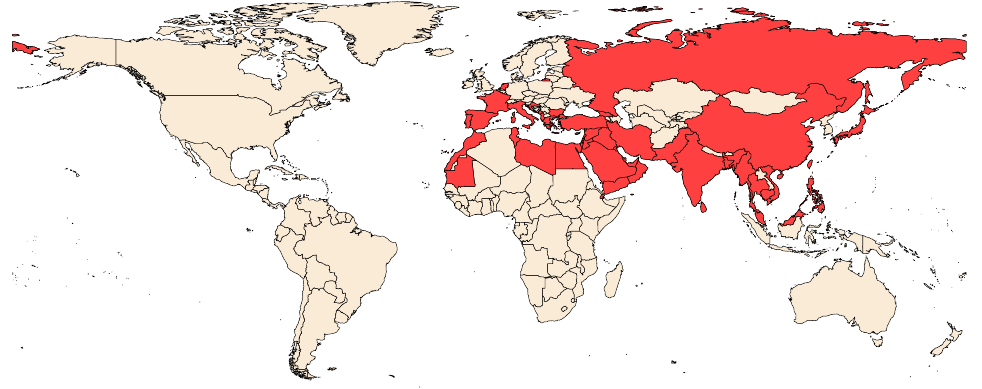
Figure 2. Geographic distribution of the red palm weevil, based on data from the Invasive Species Compendium. Available at https://www.cabi.org/isc/datasheet/47472 (Accessed 31 January 2023).